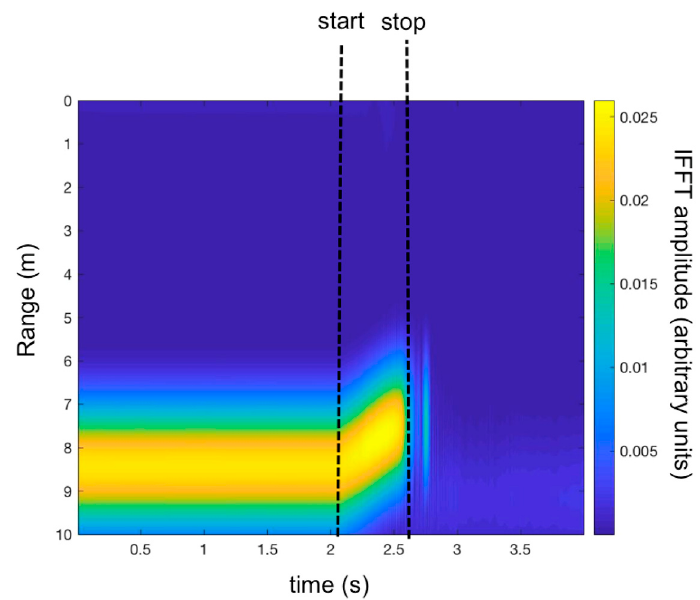
Figure 12. Time-range map of the measured IFFT (experimental set-up shown in Figure 8).